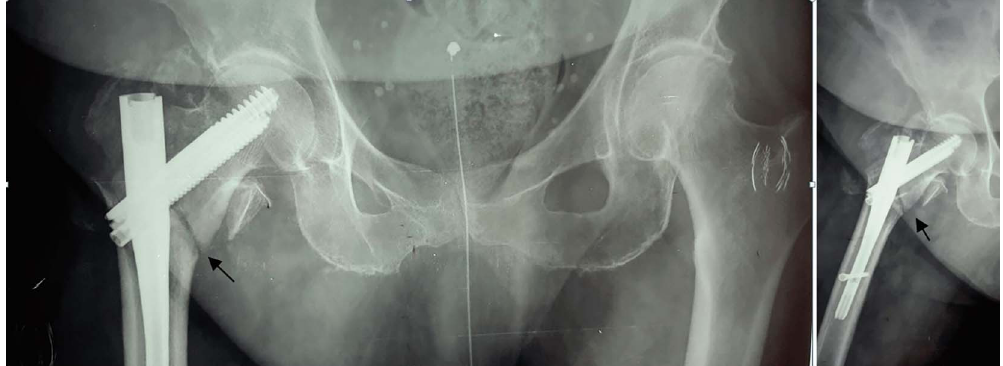
Figure 1. Final X-rays of unstable peritrochanteric fracture treated with cephalomedullary nailing (Trigen InterTAN, Smith & Nephew) and intraoperative compression at the maximum amount permitted.